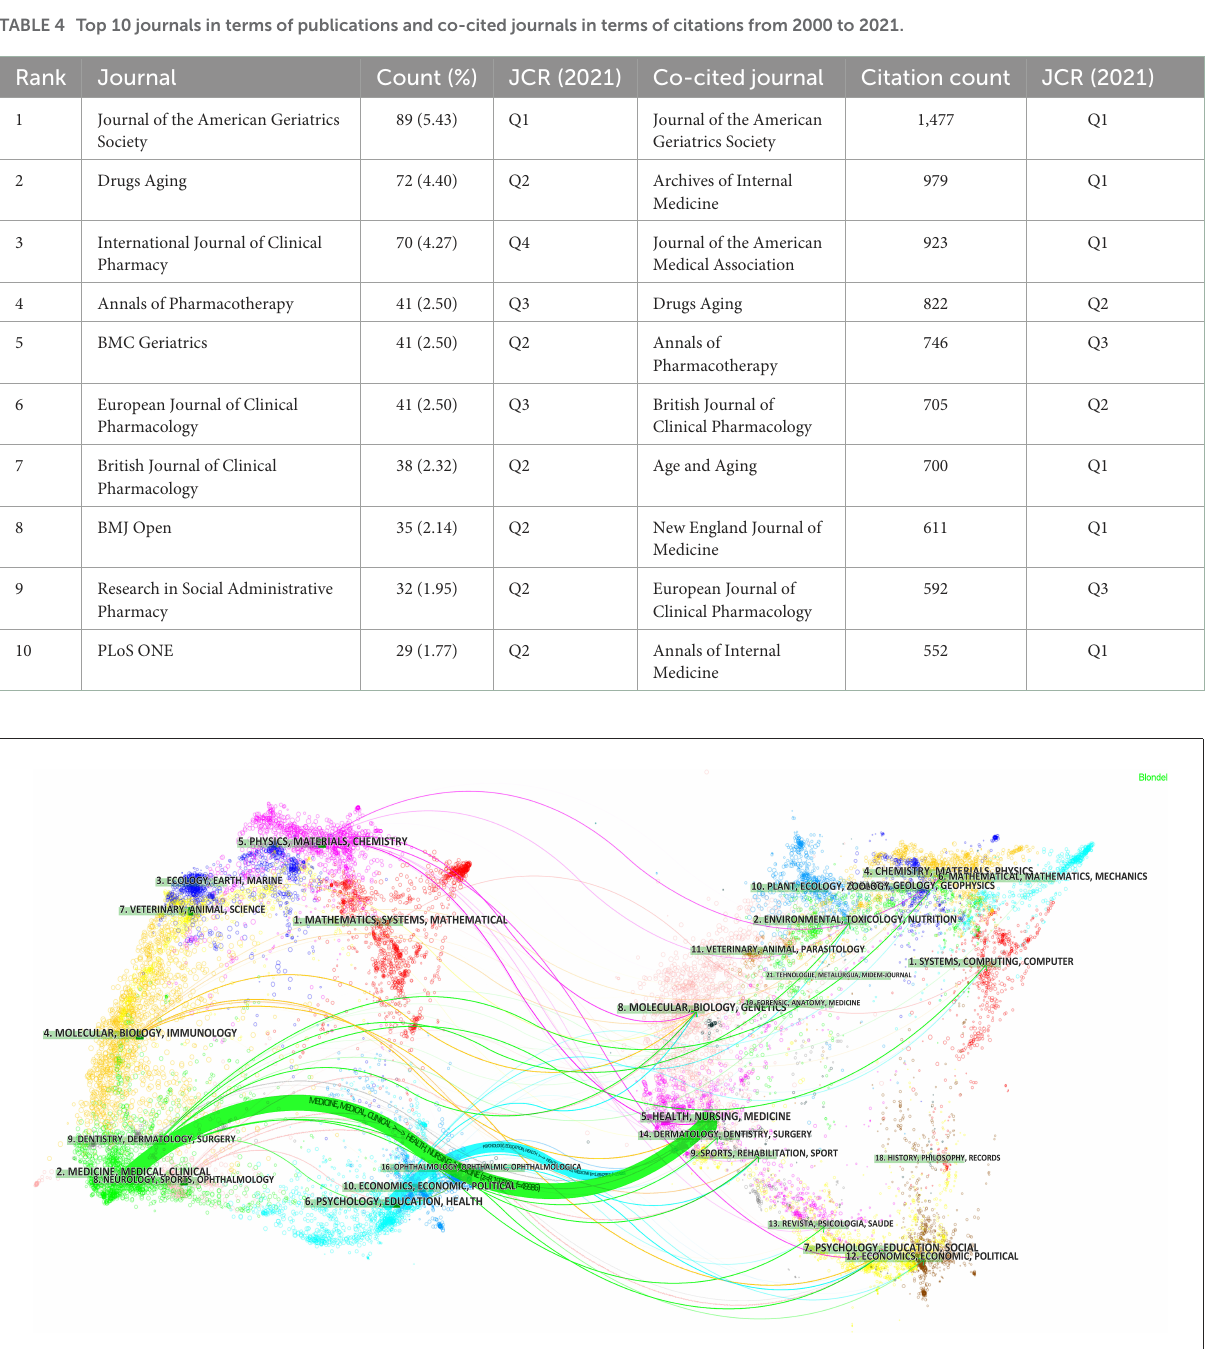
FIGURE5 The dual-map overlay of journals publishing studies on medication safety in older adults from 2000 to 2021 [ (Left) : citing journals; (Right) : cited